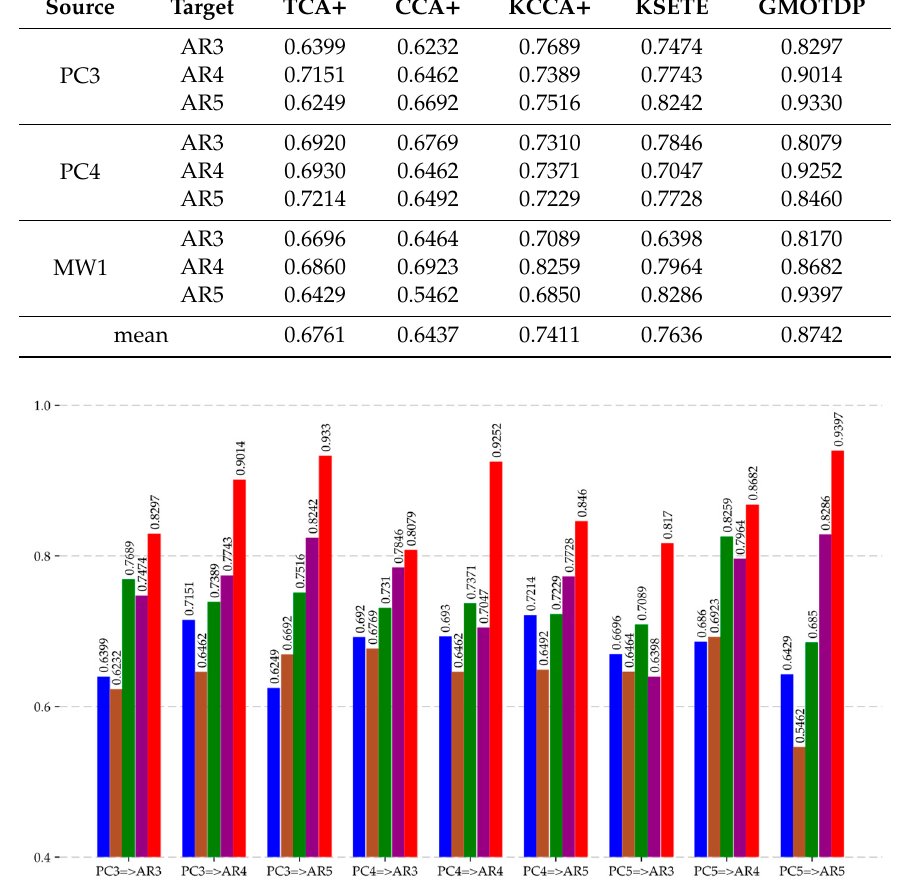
Figure 4. Results for source and target projects with common features using different methods.